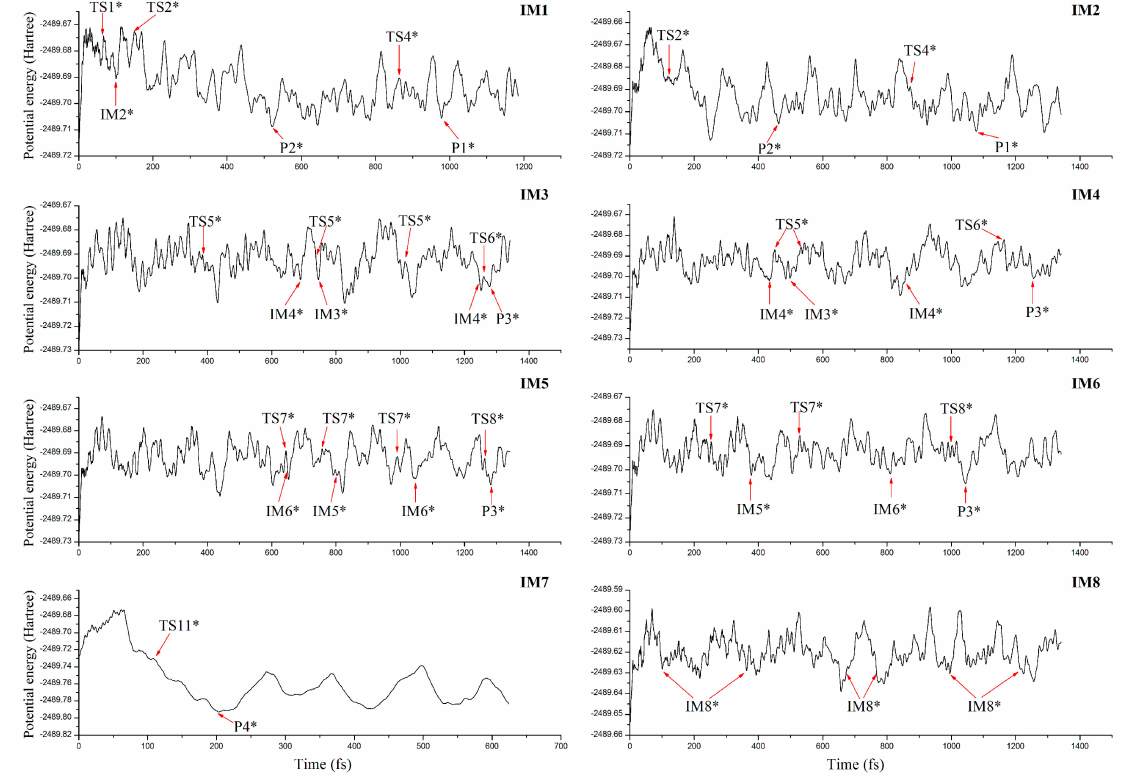
Figure 8. Evolution of the potential energy of the initial intermediates as a function of simulation time, where the asterisk denotes the selected geometry analogous to the optimized intermediate, transition state, and